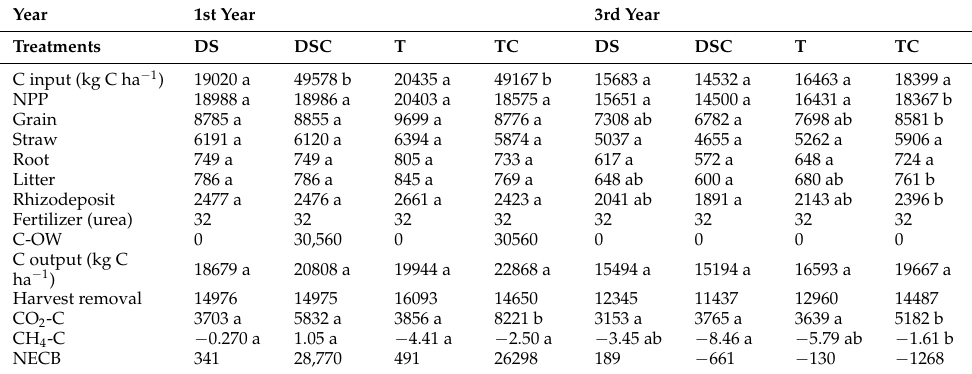
Rice cultivated by: DS, direct seeding; DSC, direct seeding compost; T, tillage; and TC, tillage compost. GWP : global warming potential; GWPr : global warming potential yield. ANOVA factors are: Y, year; T, treatment; and Y x T, interaction of year * treatment. F-values indicate the significance levels: * p < 0.05; ** p < 0.01; *** p < 0.001; and NS, not significant. Different letters indicate differences ( p < 0.05) between treatments in the same year (lower-case letters) and between years within the same treatment (upper-case letters). Table 2. Effect of rice grain productivity and net carbon balance in aerobic environments of rice on soils amended with composted olive mill wastes during investigation